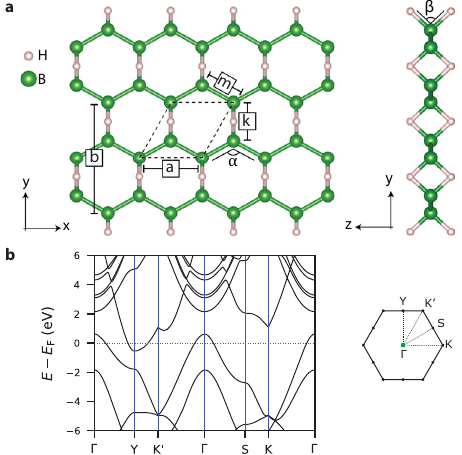
Fig. 3 HB sheets model. a Model HB sheet crystal structure with labeled measurements. b Semi-metallic band structure with electron and hole pocket at Y and Γ point.